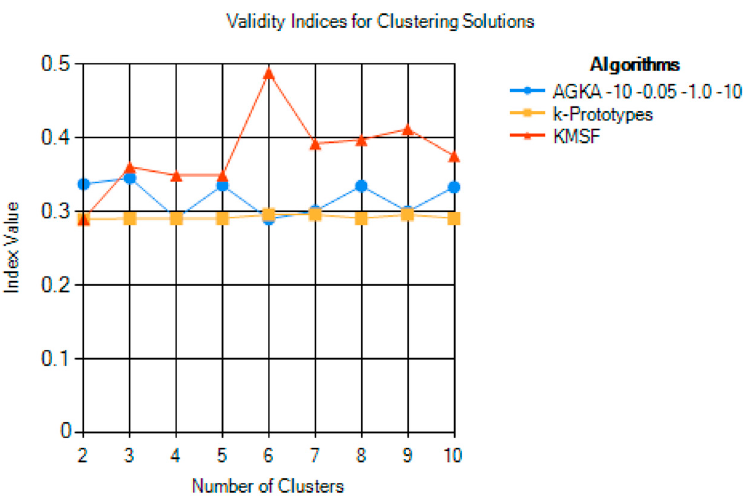
Figure 3. Results of Dunn’s index.